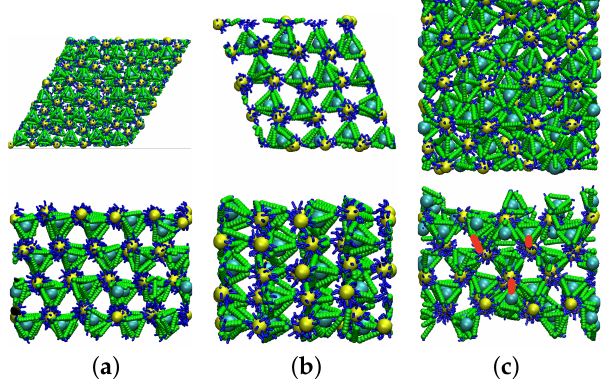
Figure 2. The snapshots of MD simulation of different finite crystal slabs with surfaces along different symmetry directions. ( a ) Top, the (110) surface, viewed normal to the free surface ( z -direction); the bottom panel is a side view. ( b ) Top, the (111) plane, viewed normal to the free surface ( z -direction); the bottom panel is a side view. ( c ) Top, the (100) plane, viewed normal to the free surface ( z -direction); the bottom panel is a side view. The extra DNA bonds are highlighted by red